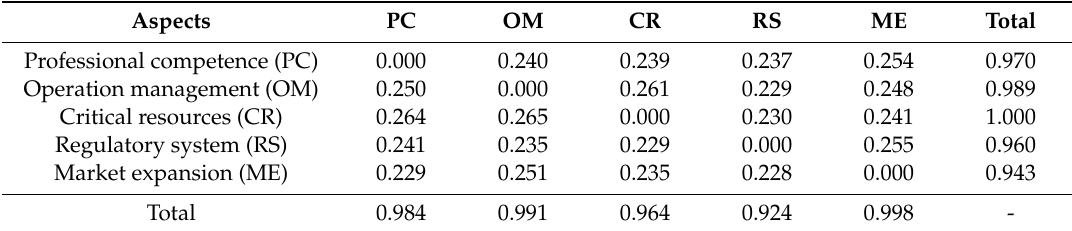
Table 5. The direct influence matrix (D).